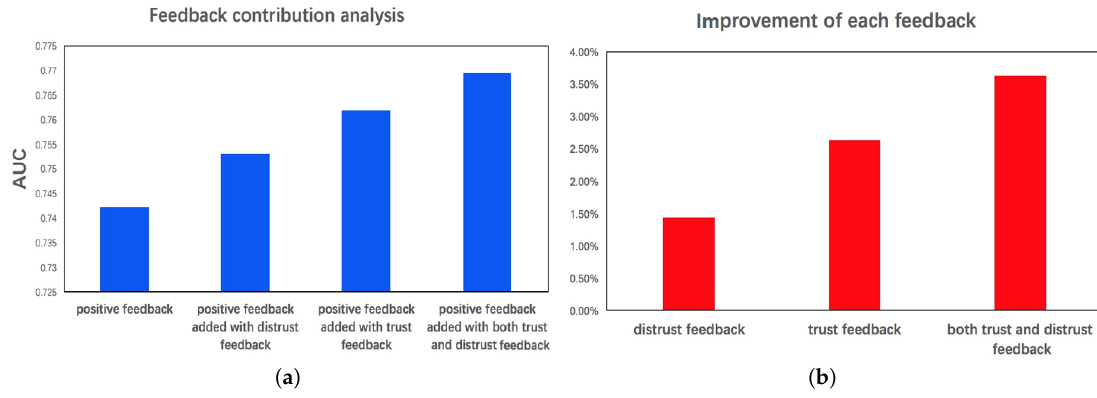
Figure 4. Feedback Analysis. ( a ) Feedback contribution analysis; ( b ) Improvement of each